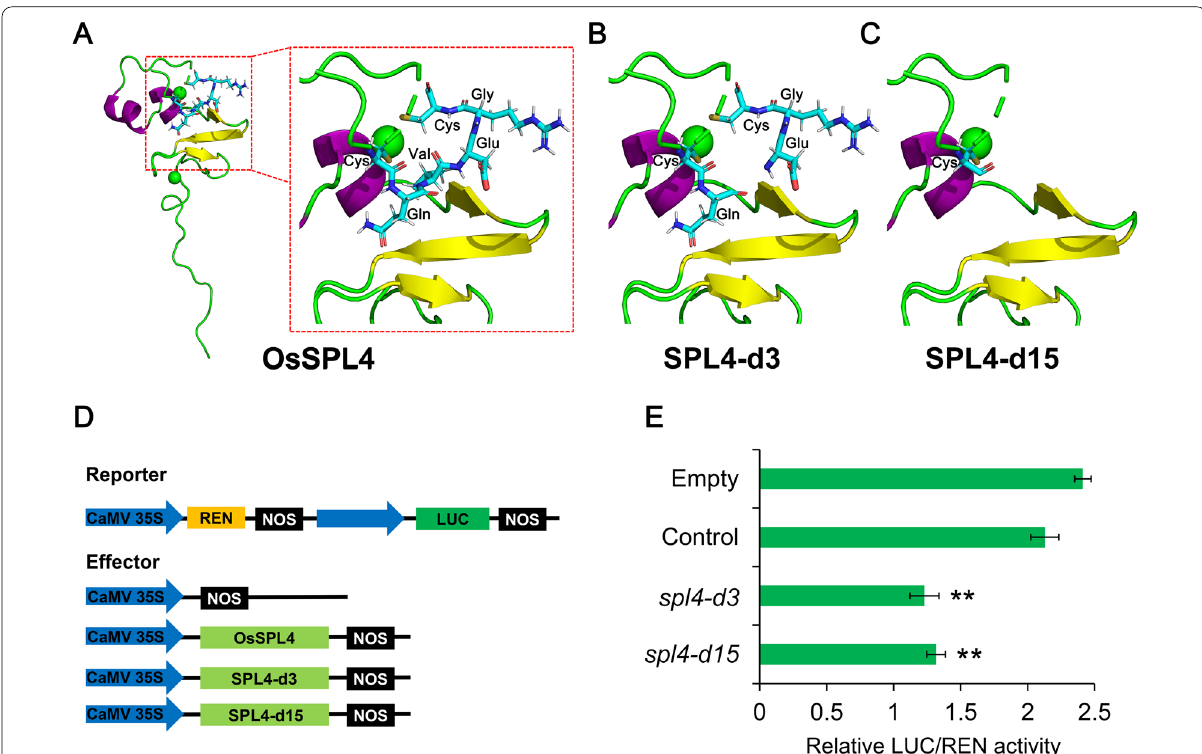
Fig. 6 Three-dimensional (3D) structures of the control and spl4-d3 plants and expression patterns of OsSPL4. A Three-dimensional homology modeling of the OsSPL4 protein based on crystallography data from Arabidopsis AtSPL4 structure (PDB ID: 1ul4.pdb). B The 3D structure of OsSPL4 in spl4-d3 lines. C The 3D structure of OsSPL4 in spl4 - d15 lines. D Schematic diagram of the reporter and effector constructs for dual-luciferase transient assays. E Effects of OsSPL4 in spl4-d3 and spl4-d15 on the transcriptional regulation in Nicotiana benthamiana . Values are means (n 3). Significant difference between control and spl4-d3 or spl4-d15 was determined by Student’s t test, * P < 0.05, ** P < =